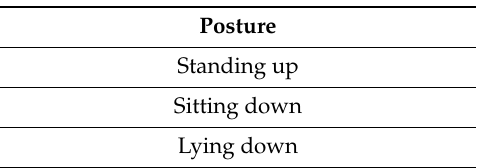
Table A2. Ethogram II. Posture Standing up Sitting down Lying